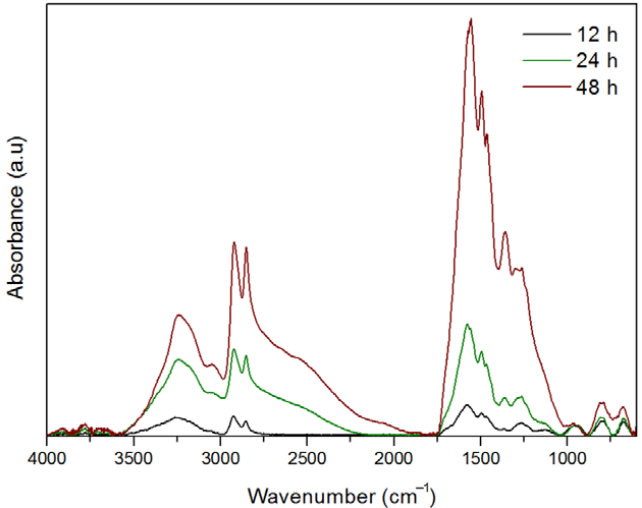
Figure 5. Fourier ‐ transform infrared spectroscopy (FT ‐ IR) spectra of the primer coatings after 12, 24 Figure 5. Fourier-transform infrared spectroscopy (FT-IR) spectra of the primer coatings after 12, 24 and and 48 h of reaction. a.u.: Arbitrary units. 48 h of reaction. a.u.: Arbitrary